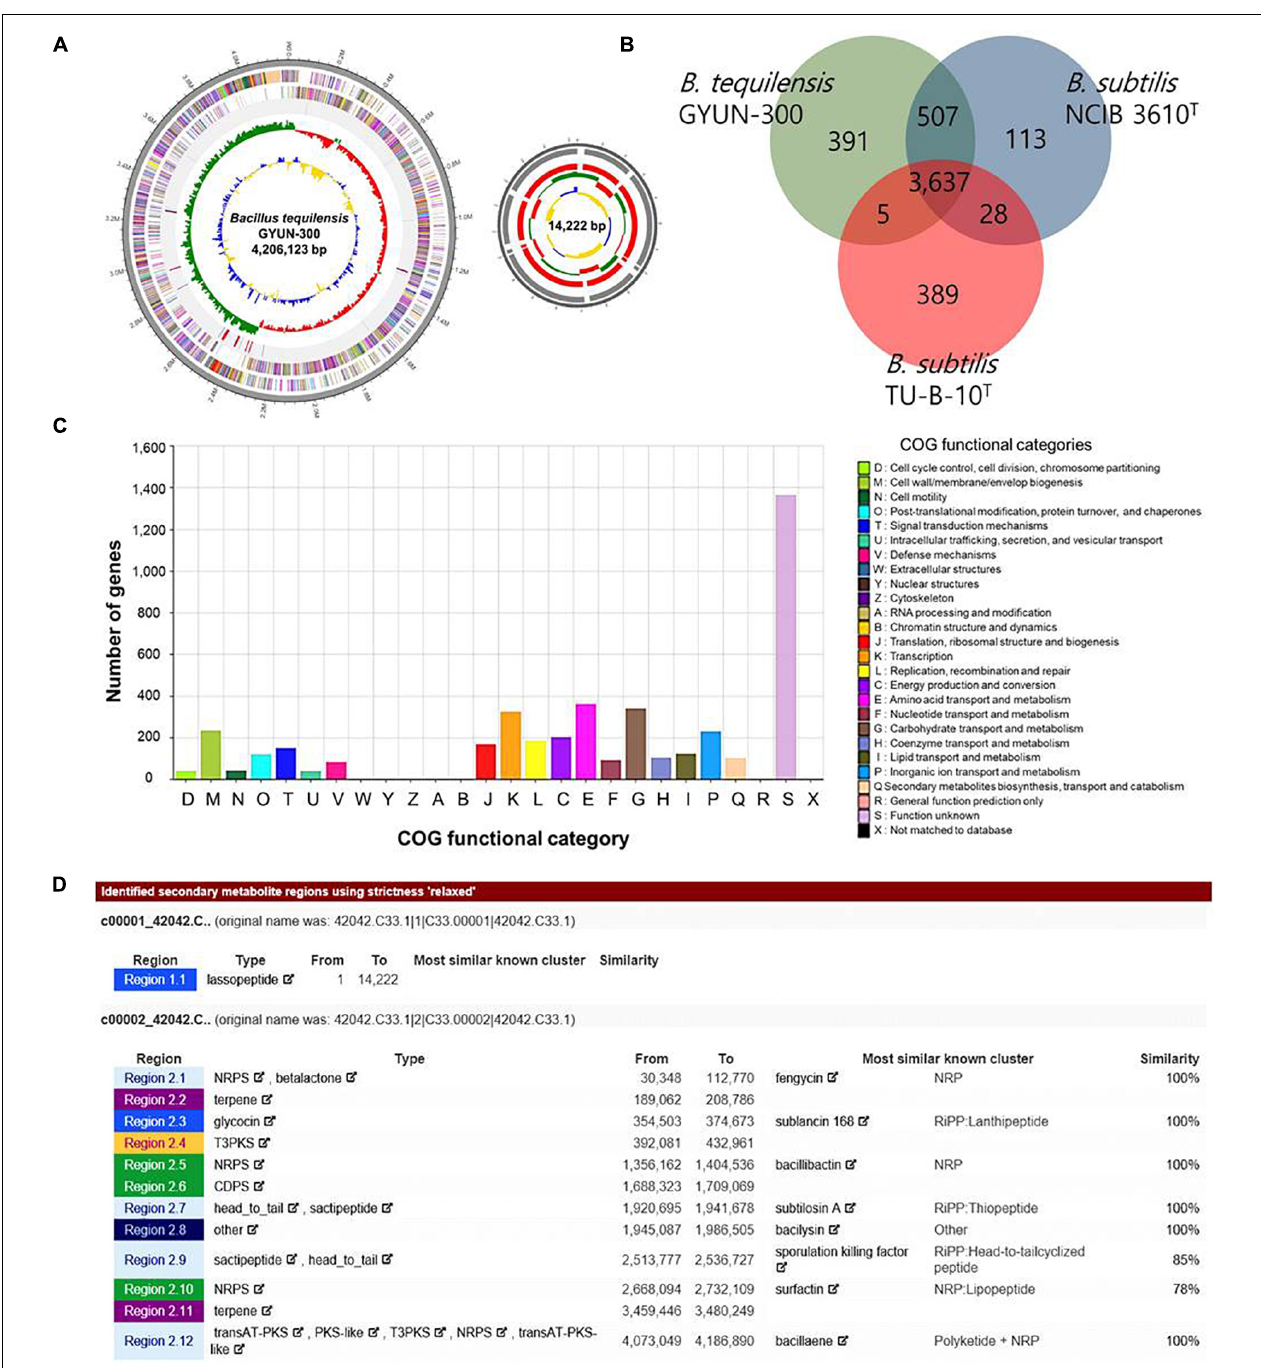
FIGURE 5 | Whole-genome map of Bacillus tequilensis GYUN-300 and annotation. (A) Marked characteristics shown from the outside to the center; coding sequence (CDS) on forward strand, CDS on reverse strand, tRNA, rRNA, guanine-cytosine (GC)-content, and GC skew. CDS genome consists of a single circular chromosome that is 4.2 mb in size, and represents one contig from the outer part of the circle; the second circle represents forward, the third represents reverse strain, and the fourth circle represents tRNA and rRNA positions; (B) distribution of orthologous genes in the Bacillus tequilensis GYUN-300, B. subtilis subsp. subtilis NCIB 3610 T , and B. subtilis subsp. spizizenii TU-B-10 T genomes. The Venn diagram shows the summary of unique SNPs from total genes of the B. tequilensis GYUN-300 strain. This analysis exploits all CDS of the genomes and is not restricted to the core genome; (C) the clusters of orthologous genes (COG) function annotation of B. tequilensis GYUN-300, and distribution of genes in different COG function categories; and (D) analysis of secondary metabolites of GYUN-300 using the antiSAMASH program.